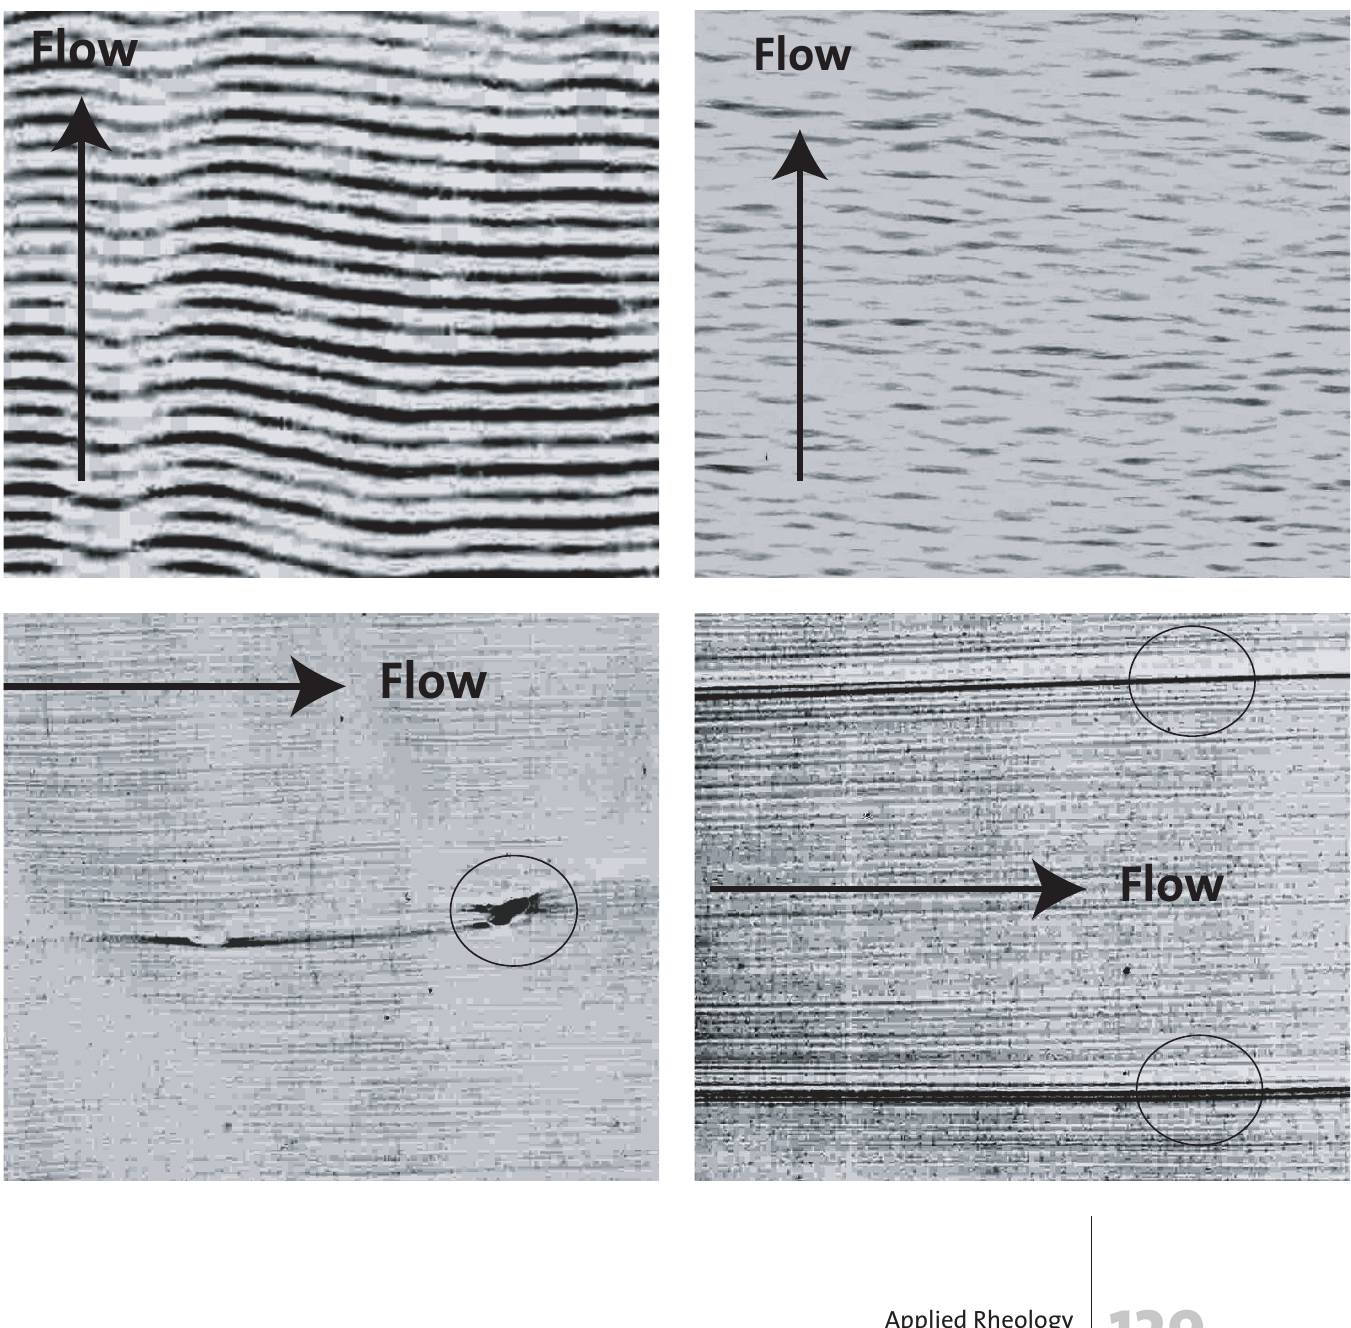
Figure 4 (left above): Melt fracture - mLLDPE Exact film sample. Figure 5 (right above): Melt fracture - mLLDPE Exceed film sample. Figure 6 (left below): Gels - mLLDPE Exact film sample. Figure 7 (right below): Weld lines - mLLDPE Exact film